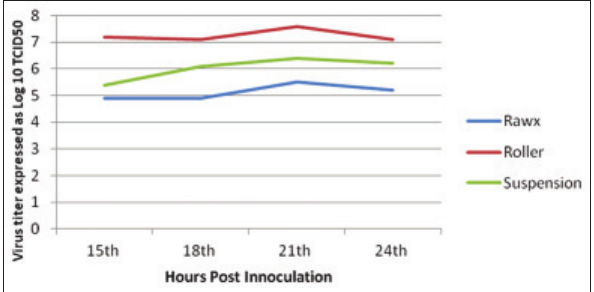
Figure-3: Effect of different cell culture systems on foot and mouth disease virus serotype (SAT-2) infectivity in baby hamster kidney-21 cell line at